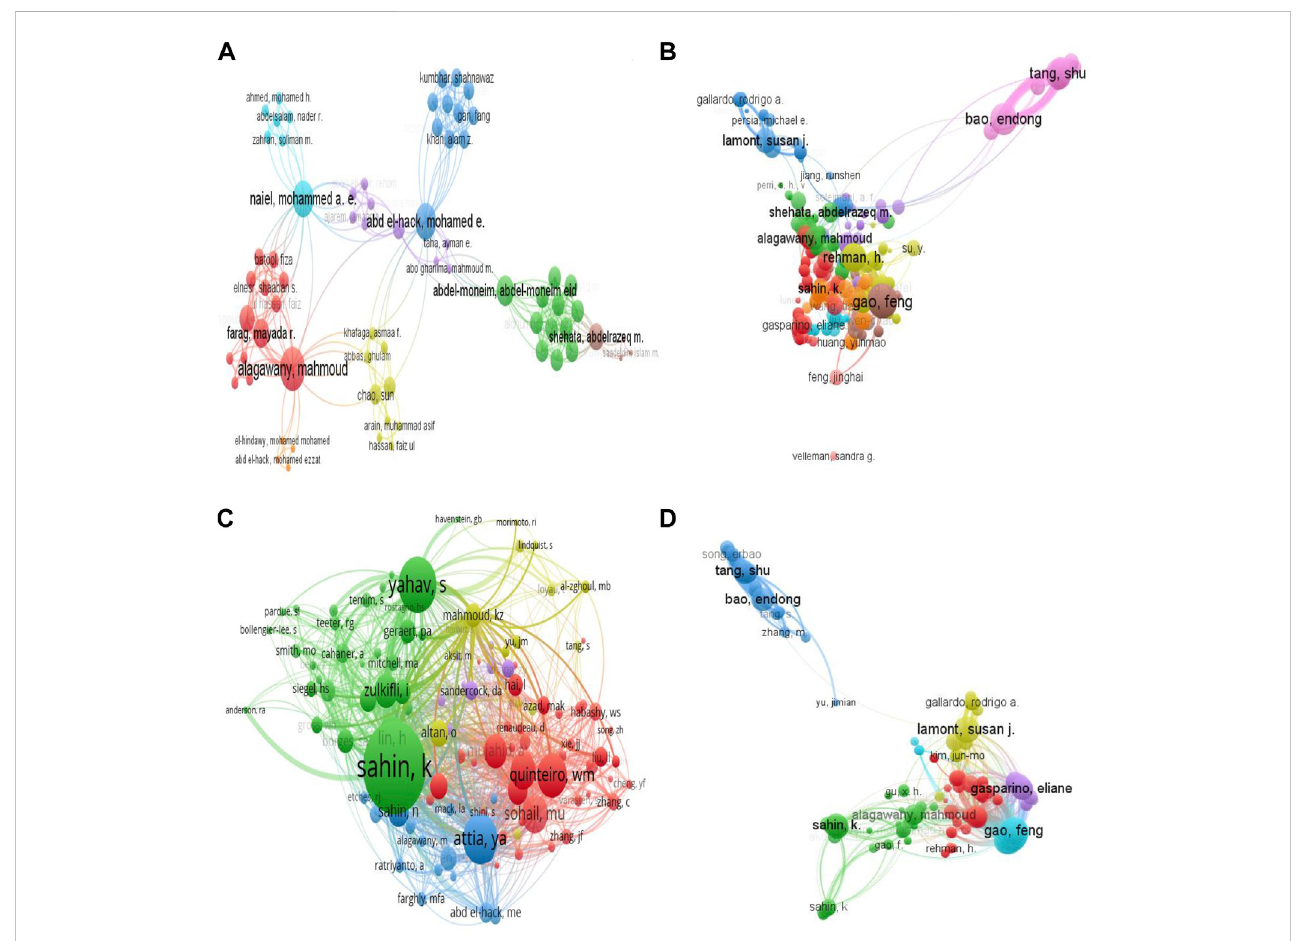
FIGURE 7 Analysisoftheauthorshipnetworkforglobalresearchonheatstressinpoultry. (A) Co-authorshipmappingofauthors. (B) Citationanalysisofauthors. (C) Co-citation analysis of authors. (D) Bibliographic coupling analysis of authors. The larger the node, the greater the author ’ s contribution, and the thicker the line, the greater the link strength between two